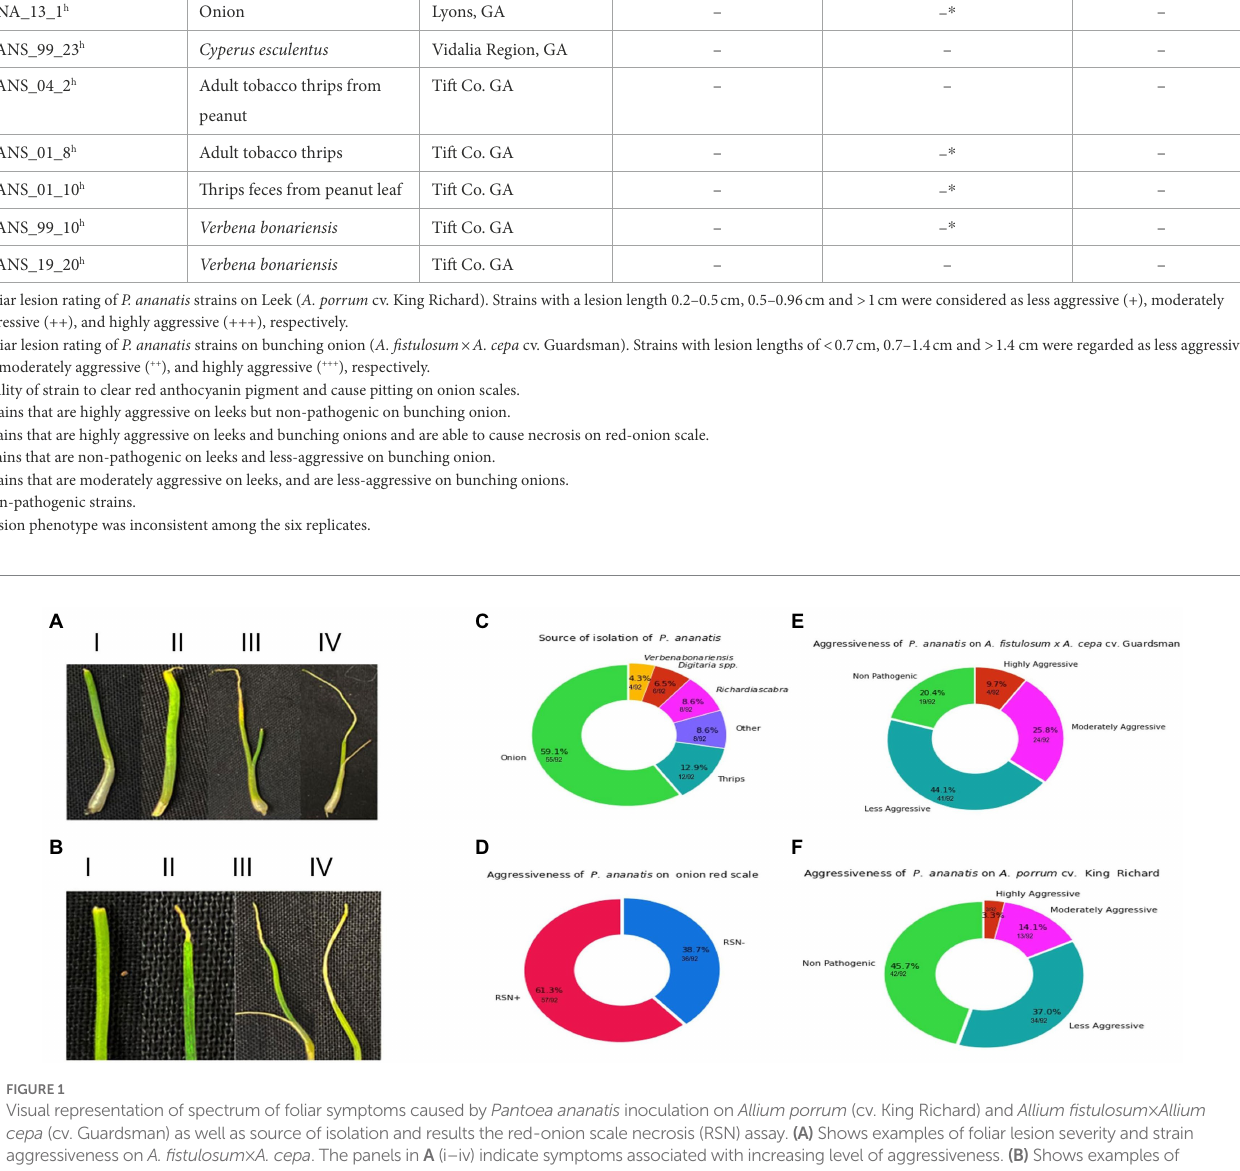
periodic fertilization. Bacterial strains were maintained on NA plates and inoculum was generated as described above. Once the primary leaf of each Allium spp. reached 9 cm, seedlings were inoculated using a cut-tip method as described previously (Dutta et al., 2014a). Briefly, a wound was created by cutting the central leaf (2 cm from the apex) with a sterile pair of scissors. Using a micropipette, a 10 μ l drop of a bacterial suspension containing 1 × 10 8 CFU/ml (1 × 10 6 CFU/leaf) was deposited at the cut-end. Seedlings inoculated with sterile water as described above